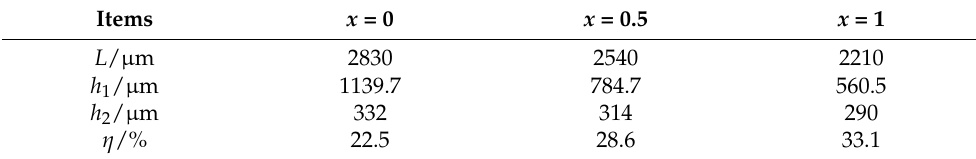
Figure 2. 3D morphologies of FeCoCrNiAl x single cladding tracks with different Al contents. ( a ) morphologies of tracks, ( b – d ) the reconstructed 3D morphologies of tracks with different Al contents. Table 2. Geometry dimension sizes and dilution rate of FeCoCrNiAl x single cladding tracks.